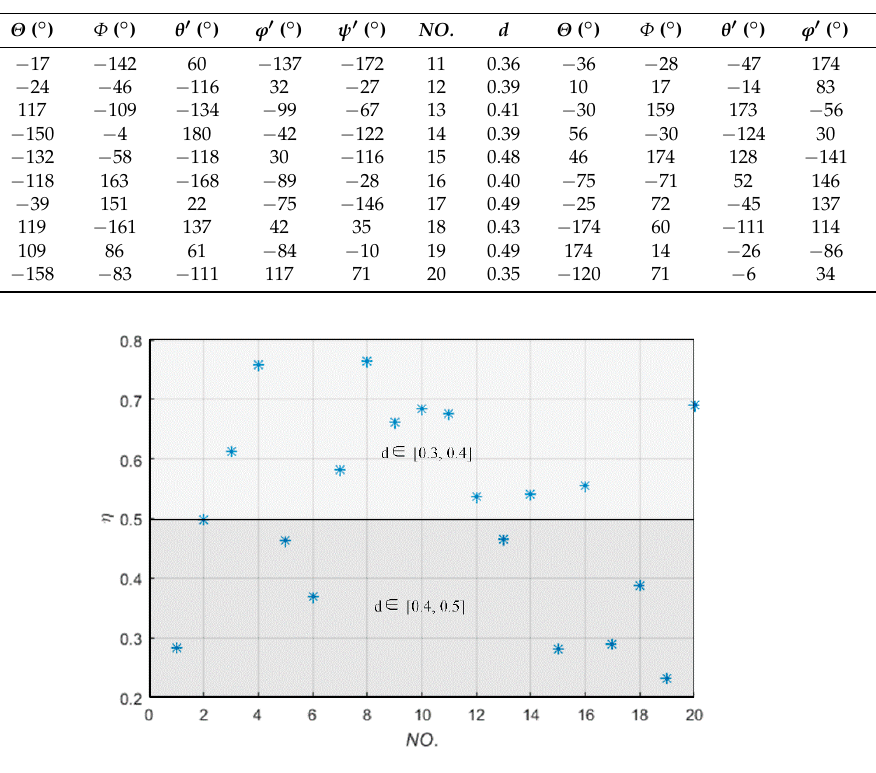
Table 4. Random sampling values of parameter set ( d , Θ , Φ , θ ′ , φ ′ , ψ ′ ).